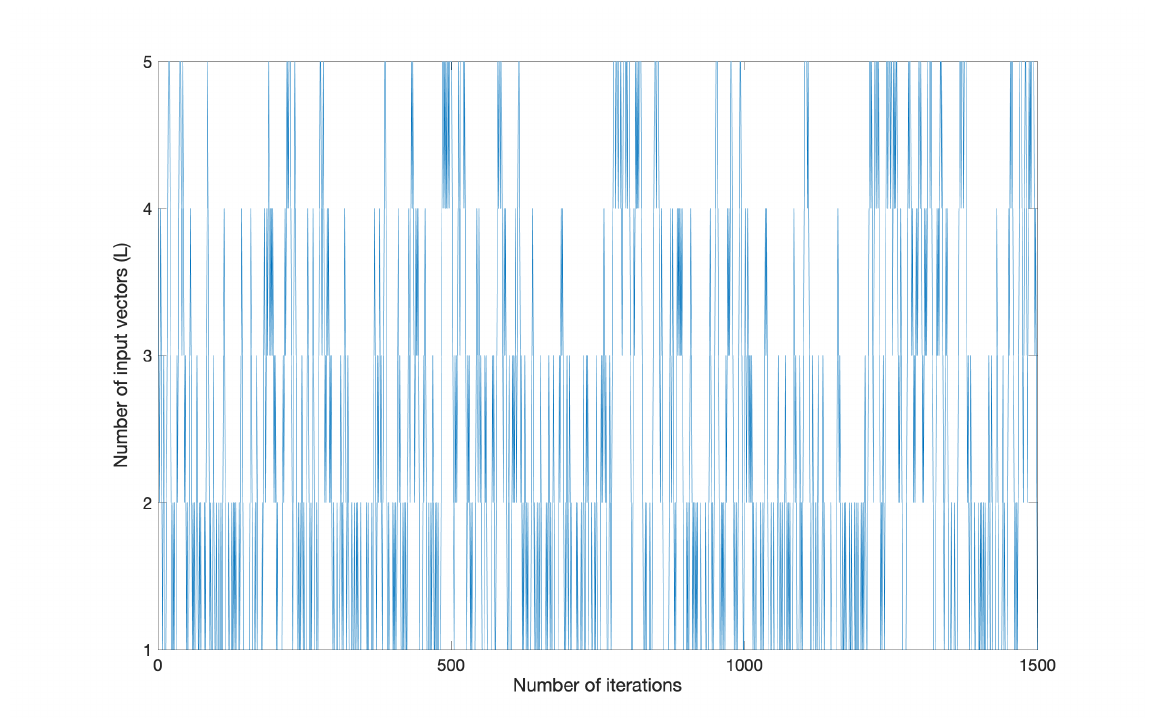
Figure 10. Zoomed view of the number of input vectors for case